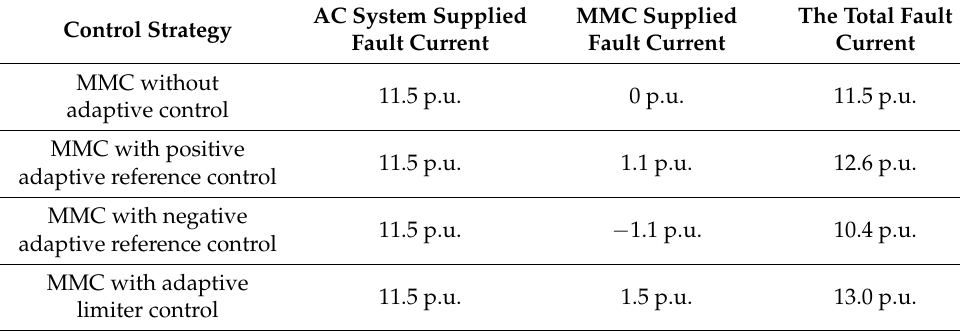
Table 3. The comparison of the different controls.